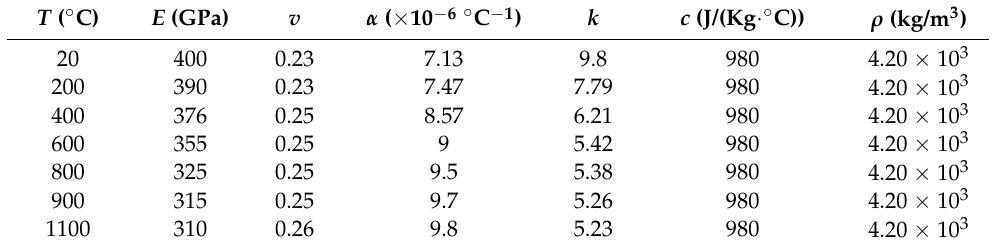
Table 5. Material parameters of Al 2 O 3 [49–51].